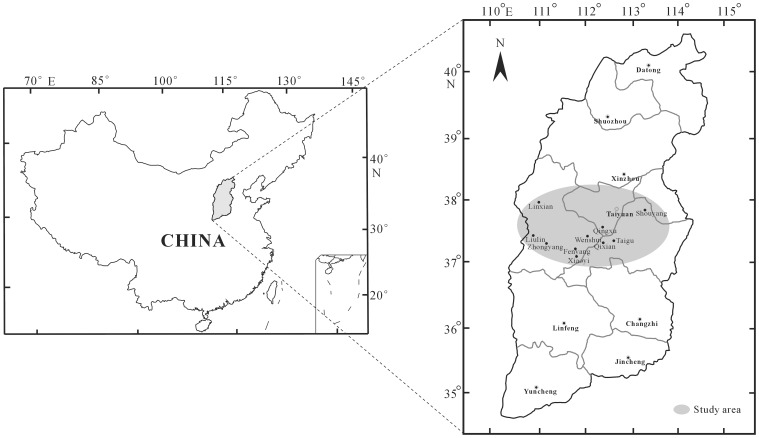
Location map showing the study area.(Left) map showing the position of Shanxi in China, (Right) map showing the sampling sites in the central region of Shanxi.